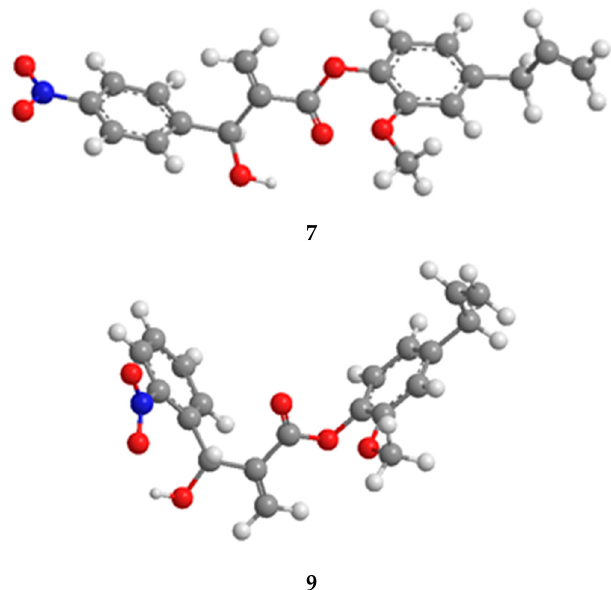
Figure 2. Conformational minima of hybrids 7 and 9 obtained by M062X//6-31+G(d,p) in implicit water simulation as the level of the calculations.